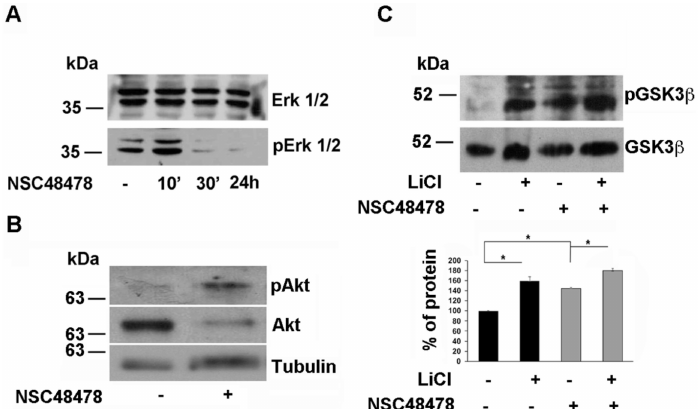
Figure 11. NSC48478 induces inactivation of ERK1 / 2 axis and activation of Akt with consequent inactivation of GSK3 β . ( A ) Total cell lysates (40 µ g) from cells treated or not with NSC48478 for indicated times, were loaded on gels and expression levels of both total ERK1 / 2 and pERK1 / 2 were analysed by SDS-PAGE followed by Western blotting and hybridization of PVDF membranes by respective antibodies. ( B ) Total cell lysates (40 µ g) from cells treated or not with NSC48478, were loaded on gels and expression levels of both total Akt and pAkt were analysed by SDS-PAGE followed by Western blotting and hybridization of PVDF membranes by respective antibodies. Anti-tubulin antibody was used to test loading controls. ( C ) The membranes were treated as in ( B ) with the exception that here the cells were incubated with LiCl (10 mM for 24 h) to inhibit GSK3 β pathway, in the presence or absence of NSC48478. Both total and pGSK3 β levels were revealed by using anti- GSK3 β and anti-phospho-Ser9 GSK3 β antibody, respectively. The amount of pGSK3 β was quantified as “percent of protein” in the plot from three independent experiments (* p <